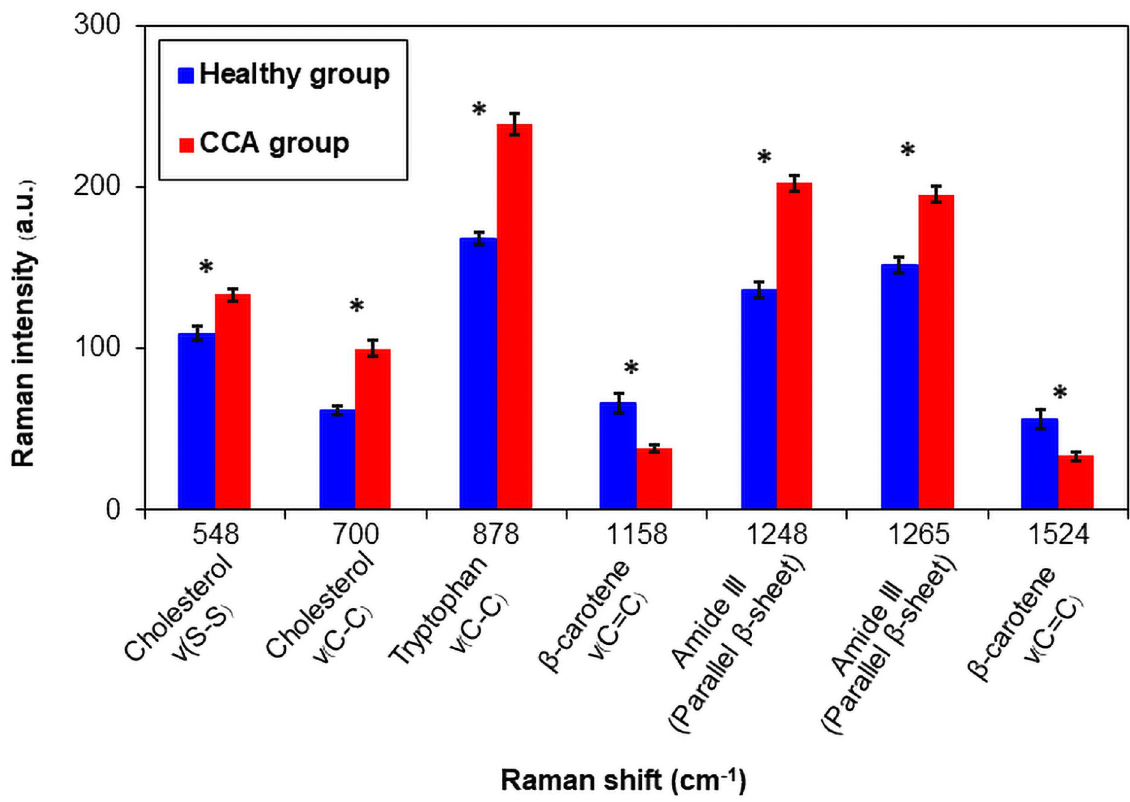
Fig 3. Comparison of averaged Raman peak intensities between the CCA and healthy groups. The Raman peak height values were calculated using a Gaussian–Lorentzian function. Data shown represent mean ± standard error of the measurements (150 total measurements for each group). Significant differences (p-value � 0.05) are indicated by � . ν : stretching